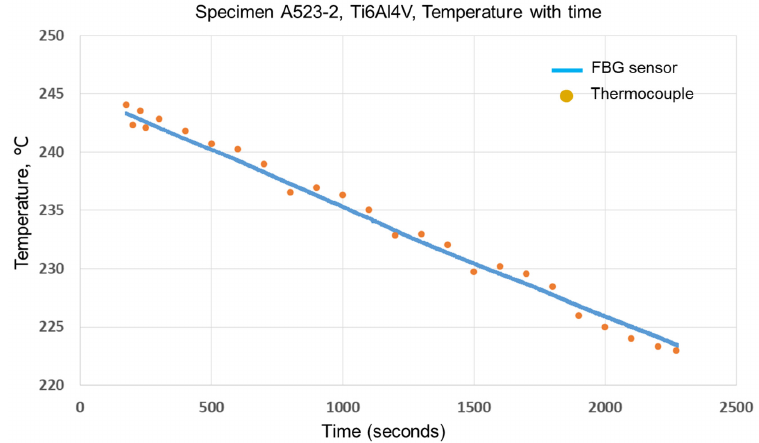
Figure 11. Temperature data acquired using embedded FBG sensor and thermocouple on Ti6Al4V specimen A523-2.